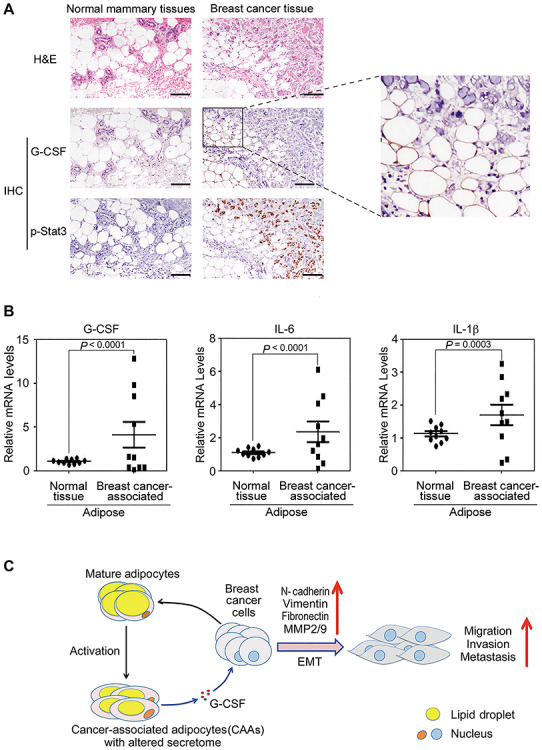
Clinical implications of G-CSF in adipocyte–breast cancer interaction. (A) Normal mammary tissues and breast cancer tissues were examined for G-CSF and p-Stat3 expression by H&E staining and IHC analysis. Scale bar, 200 μm. (B) Total RNAs were extracted from the adipose tissues. Gene expression levels were assessed by q-PCR and analyzed by GraphPad Prism5. (C) Schematic diagram shows the critical roles of G-CSF in adipocyte/CAA–breast cancer interplay. Breast cancer cells are able to convert adipocytes into CAAs that exhibit altered gene transcription pattern. In particular, G-CSF, which is highly expressed and secreted by CAAs, activates Stat3 signaling in TNBC cells. The G-CSF/Stat3 signaling then drives TNBC cell malignant progression by promoting EMT and invasion.